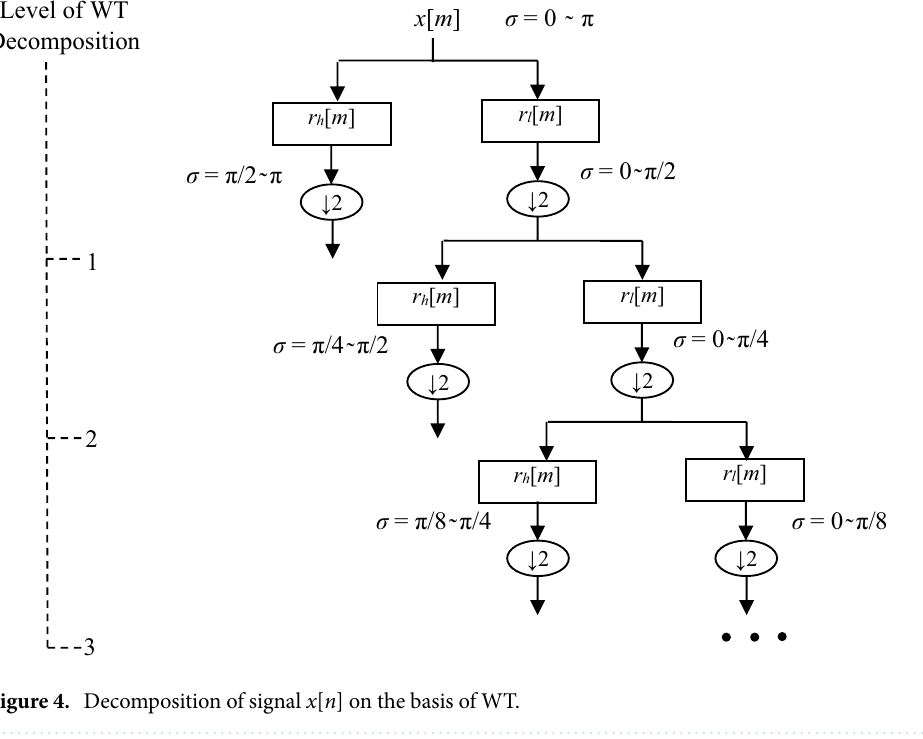
Figure 4. Decomposition of signal x [ n ] on the basis of